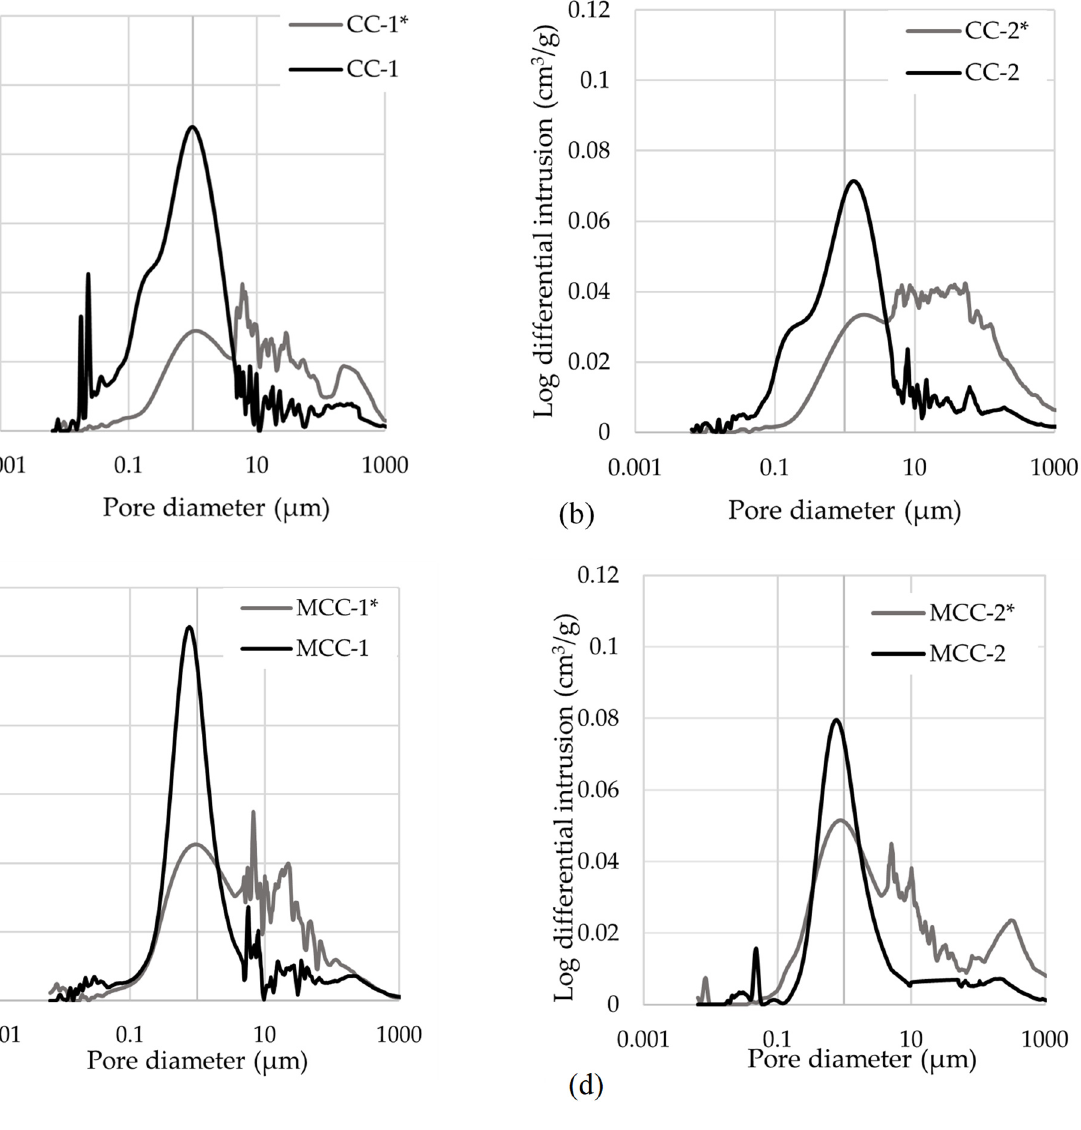
Figure 7. Result of castable porosity before and after 3 cycles of alkaline attack (*): ( a )—CC-1; ( b )—CC-2; ( c )—MCC-1; ( d )—MCC-2.